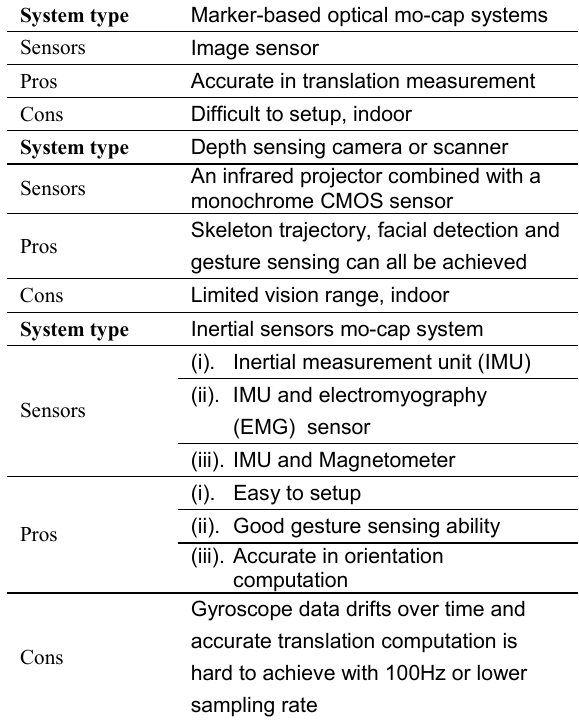
Table 1. Comparison of marker-based optical motion cap- ture (mo-cap) system, depth sensing camera or scanner and inertial sensors mo-cap